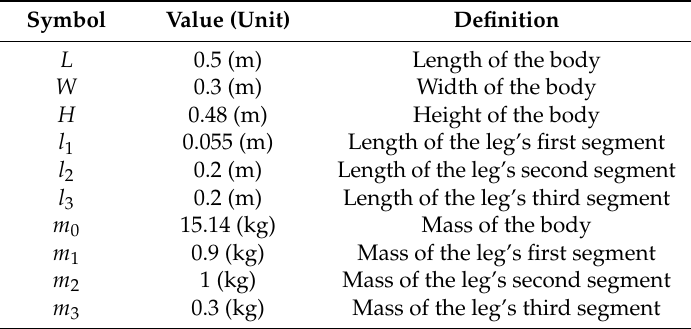
Table 1. Geometric and weight parameters of the robot.